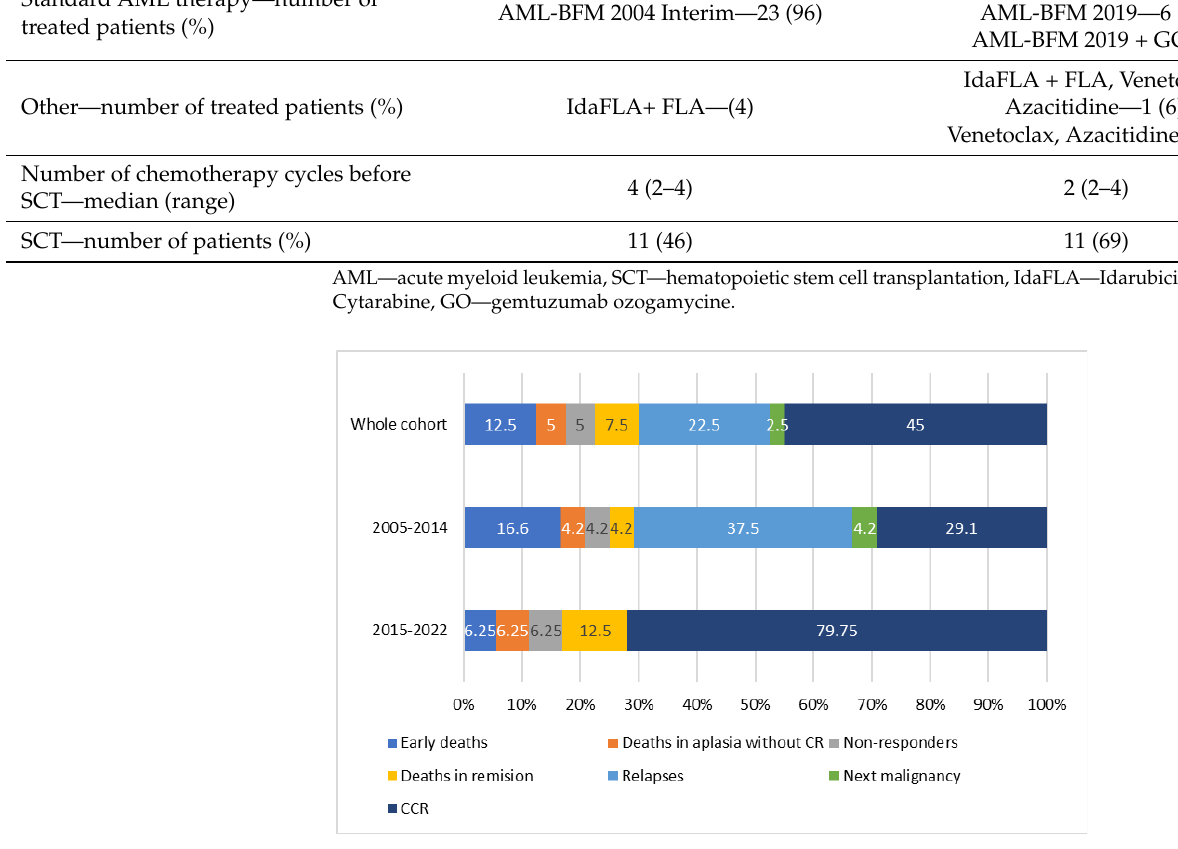
Figure 1. Treatment results in the whole cohort and two periods (2005–2014 and 2015–2022). CR— complete remission, CCR—continuous complete